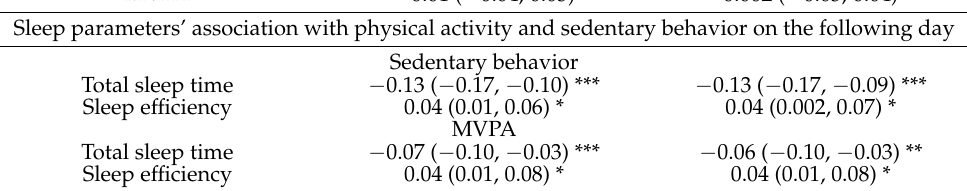
Model 1: control for MVPA or sedentary behavior; Model 2: control for Model 1 and age, sex, fitness, and cognitive performance. MVPA: moderate-to-vigorous physical activity; TST: total sleep time; SE: sleep efficiency. p